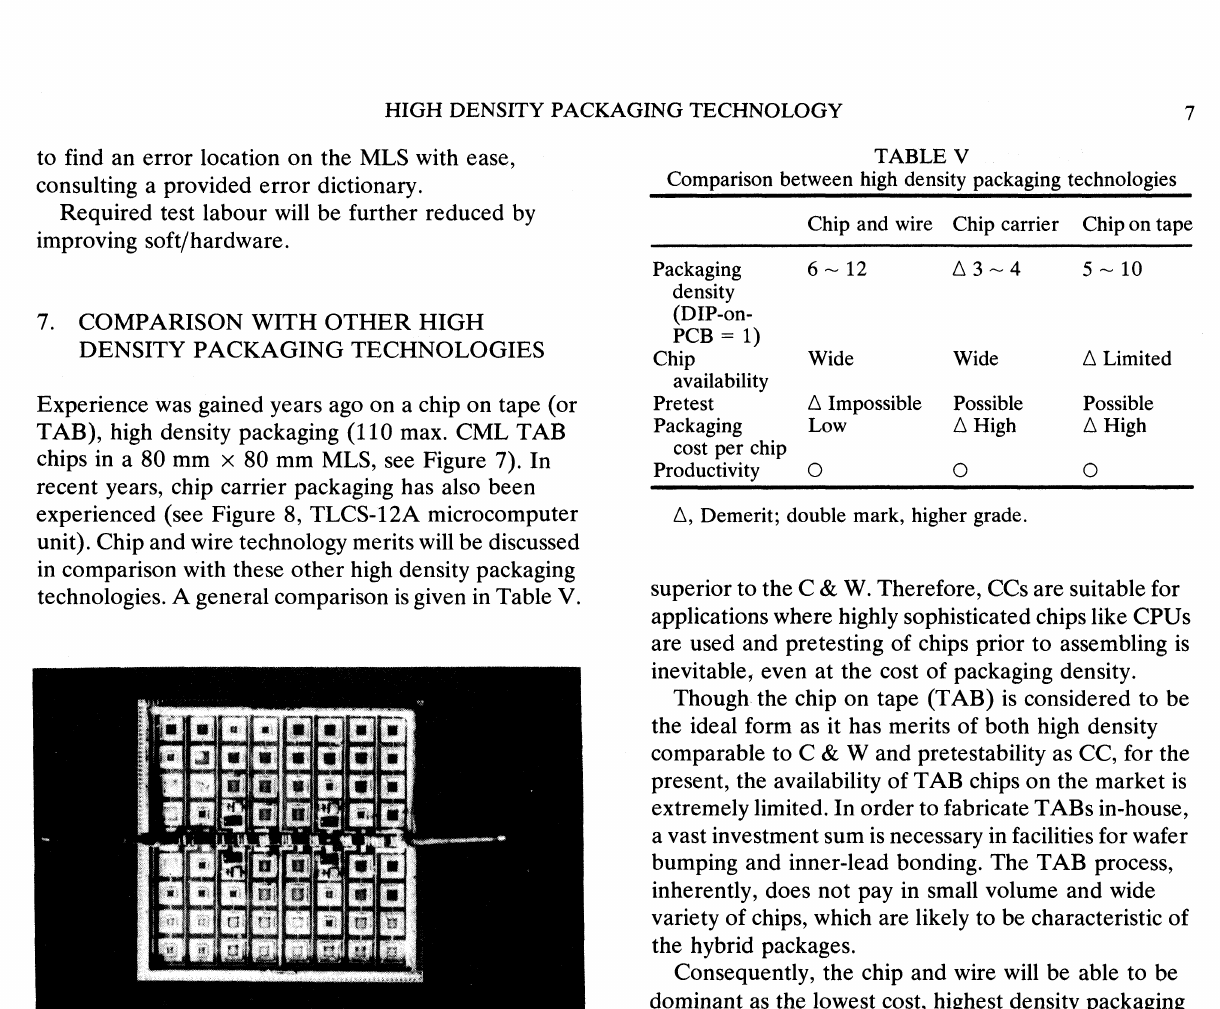
FIGURE 7 Chip-on-tape high density packaging (logic package for a large computer).